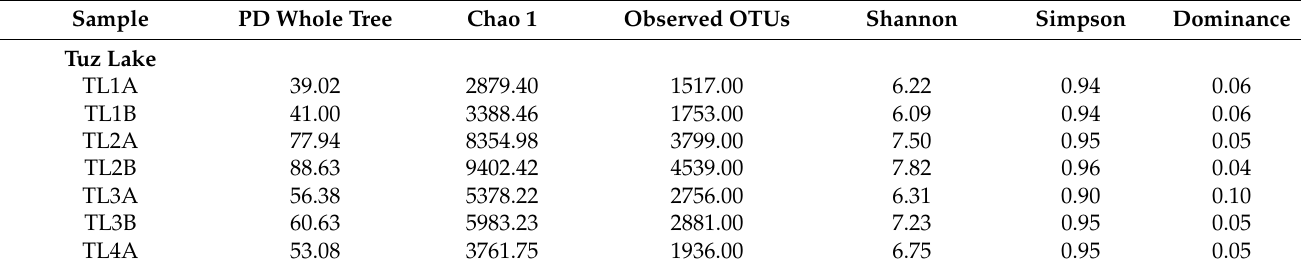
Table 1. Prokaryotic richness and diversity estimates, based on 97% OTU clusters of Tuz Lake, Deep Zone, and Kay- acik, Kaldirim, and Yavsan salterns. The diversity indexes: PD Whole Tree, Chao1, Shanon, Simpson, and Dominance were calculated.